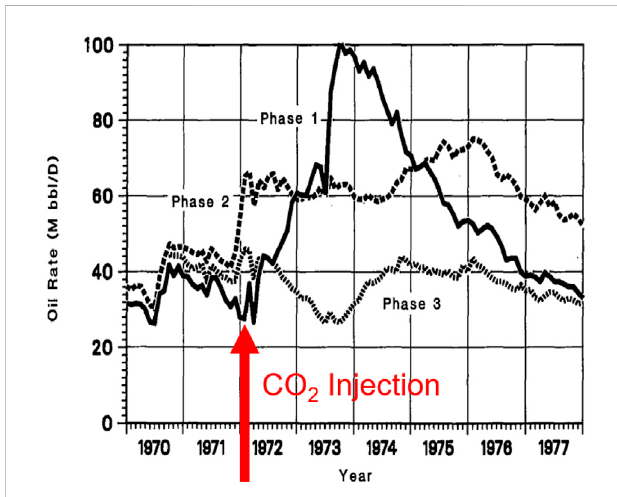
FIGURE 4 SACROC oil production rates with initial CO 2 injection overlain. Modi fi ed after Langston et al.